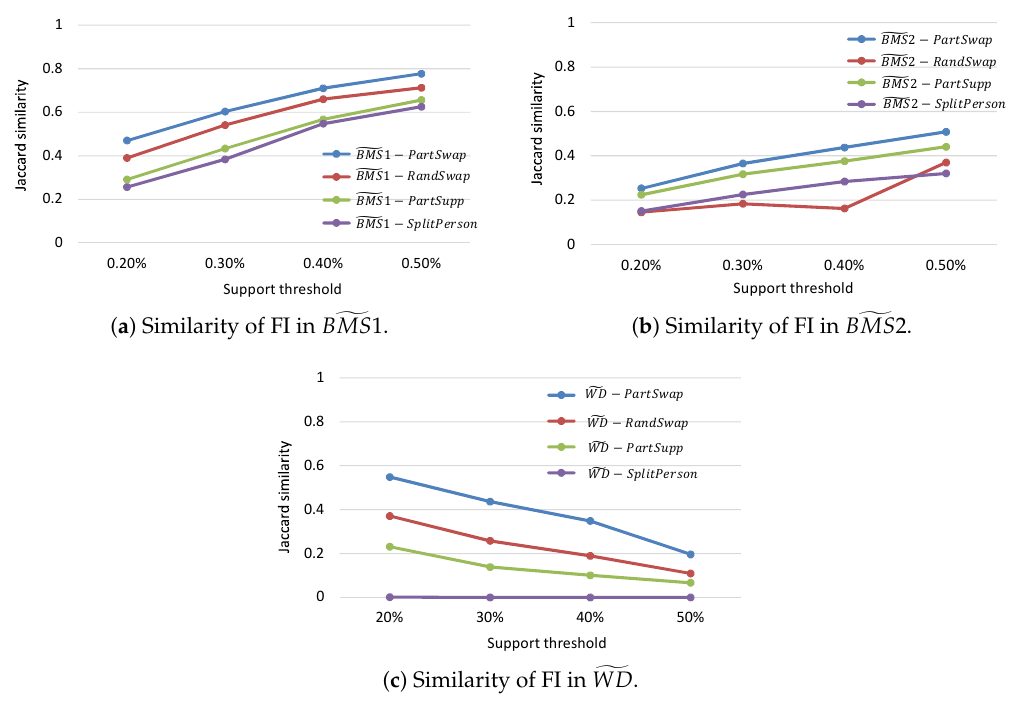
Figure 4. Comparison of the frequent itemset similarity among anonymized datasets to the original datasets.